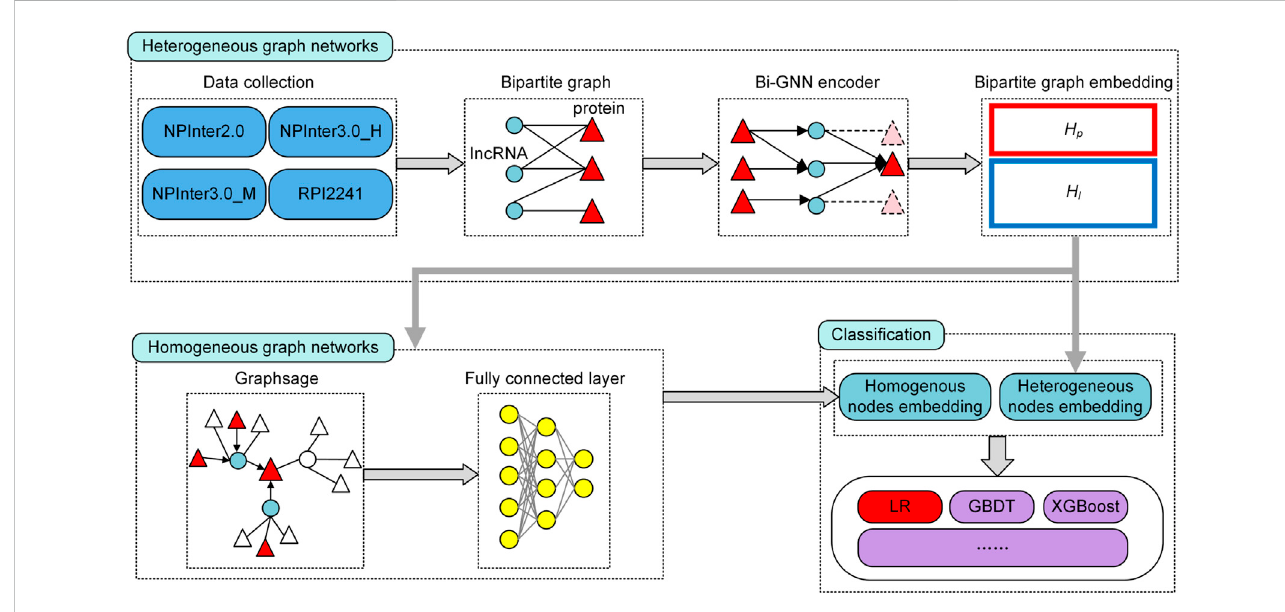
FIGURE 2 The structure of BiHo-GNN.